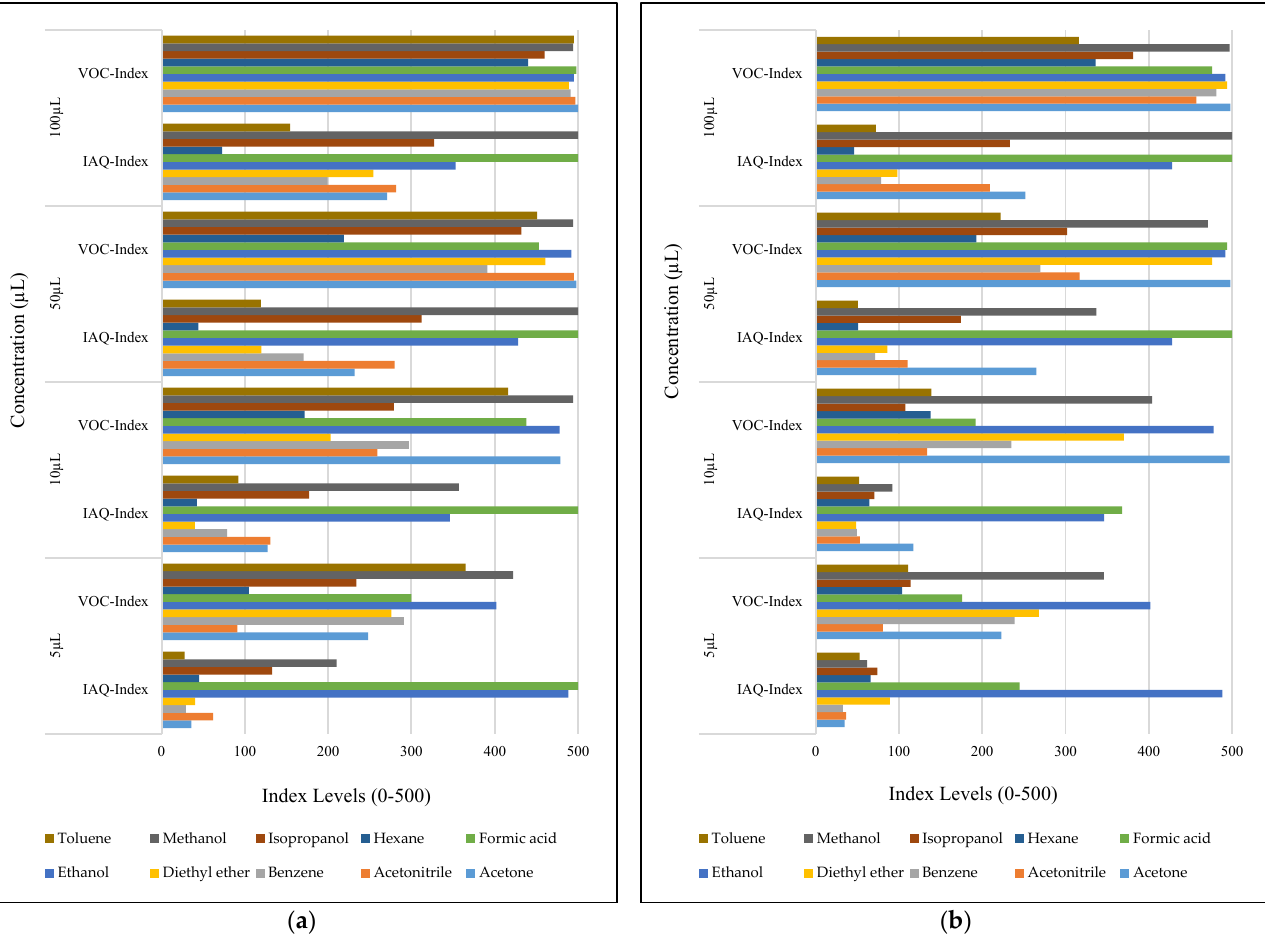
Figure 23. Maximum sensor responses for the tested VOCs from ( a ) 40 cm distance, ( b ) 100 cm distance. The step time response for the SGP41 sensor for VOC-Index shows that the maximum recorded T90 time is 268.2 s for 100 µ L of acetonitrile while the minimum recorded T90 step time response is 96.3 s for 100 µ L of benzene. The step time response for the IAQ-Index of the BME688 sensor behaves differently with the selected/tested VOCs, where the maximum recorded T90 is 390.6 for 100 µ L of benzene while the minimum recorded T90 response time is 27 s for 100 µ L of formic acid. Furthermore, the maximum recorded recovery time for the SGP41 VOC-Index is 1210 s for a 100 µ L of methanol sample from a 40 cm